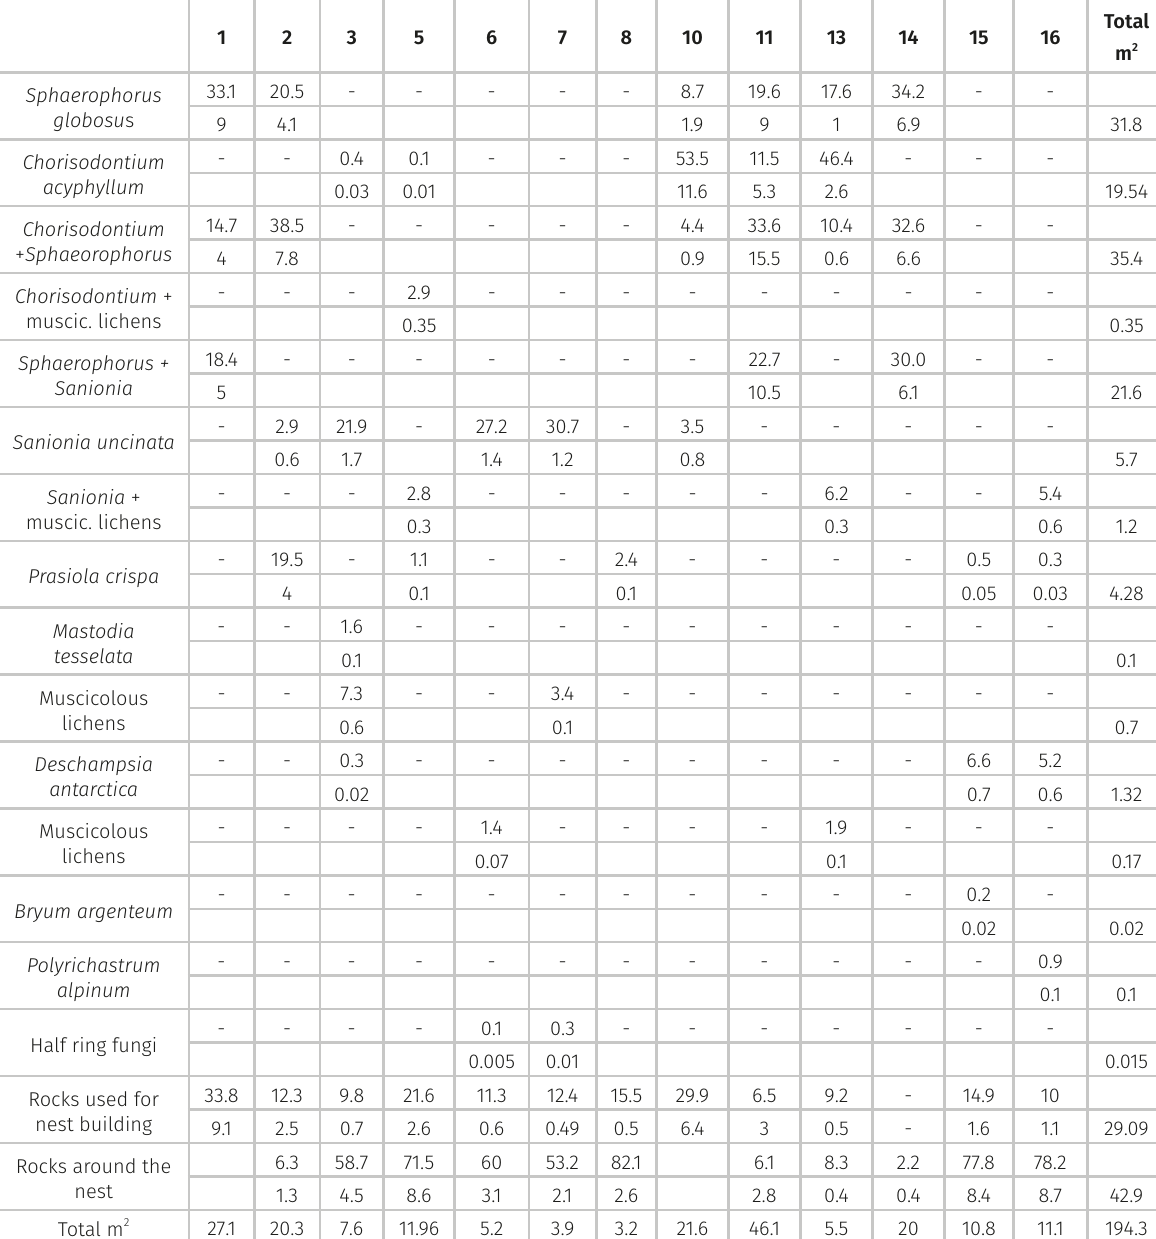
Table II. Plant species cover (%), area of rocks covering the soil used in the nest building and surroundings (%) and total area (m 2 ) around giant petrel nests in Stinker Point – Elephant